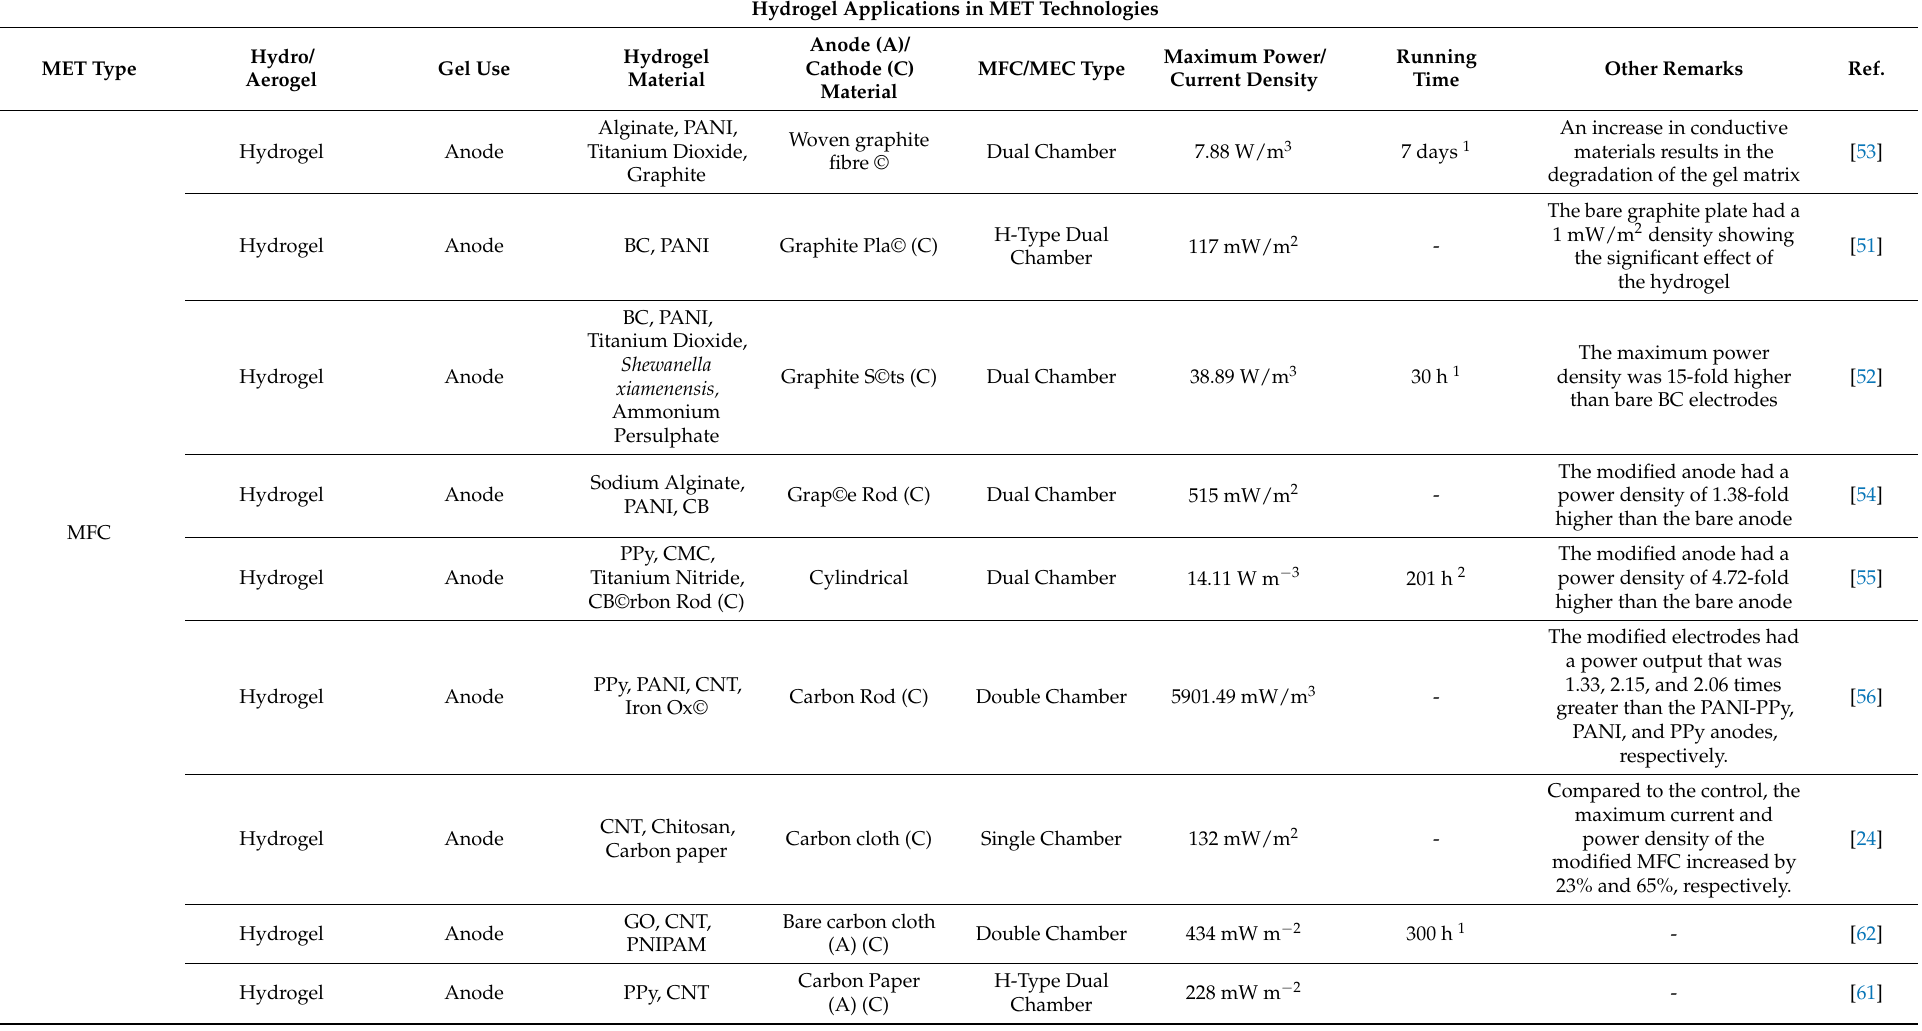
Table 2. Summary of hydrogels and aerogels used in MFCs and